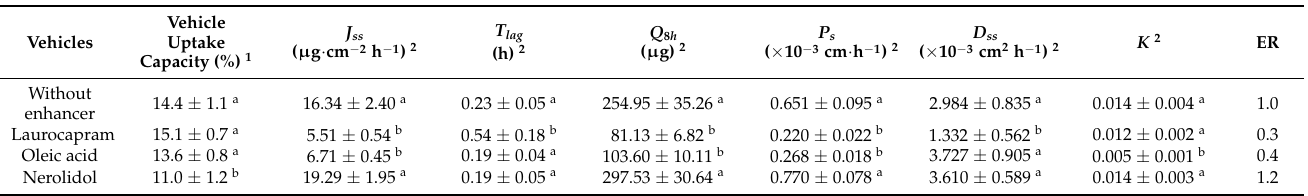
Table 6. Effect of combined enhancers on vehicle uptake capacity of mucosa and ex vivo permeation parameters of CBD with DEGEE:MCT